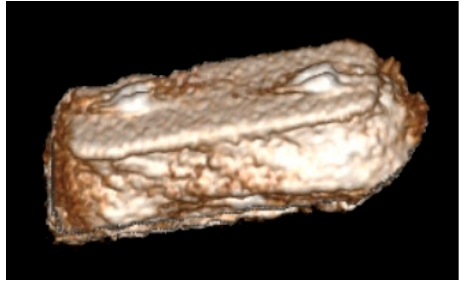
Figure 3. Volumetric evaluation of a grafted site.